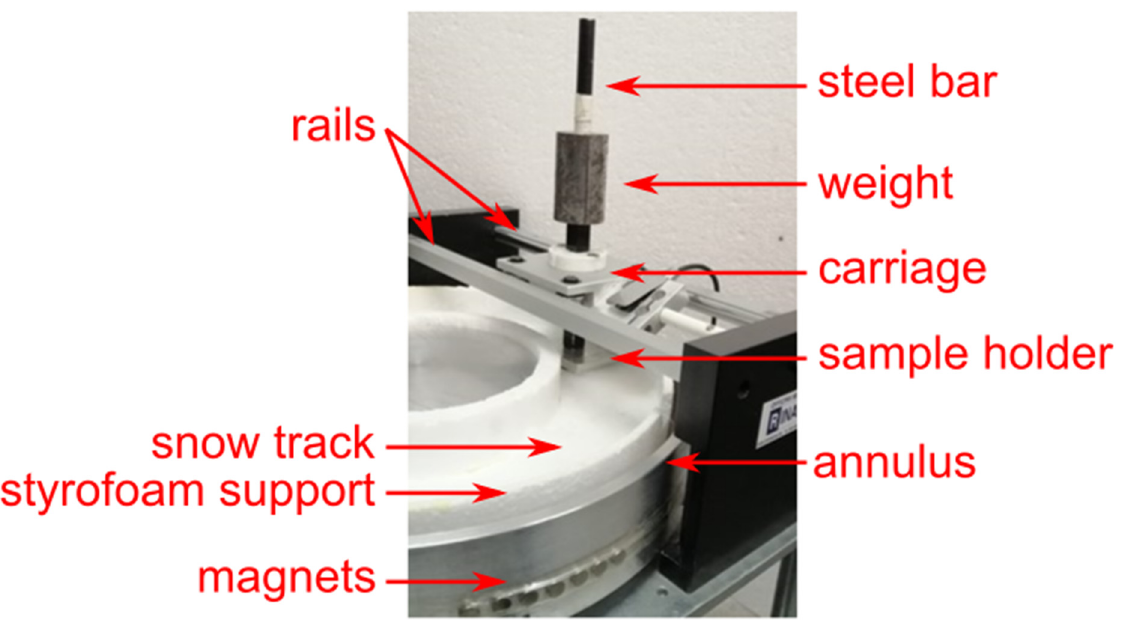
Figure 1. Snow tribometer with the Styrofoam container filled with snow inserted inside the aluminum annulus. The sample is held in place by the carriage and leans above the snow surface.